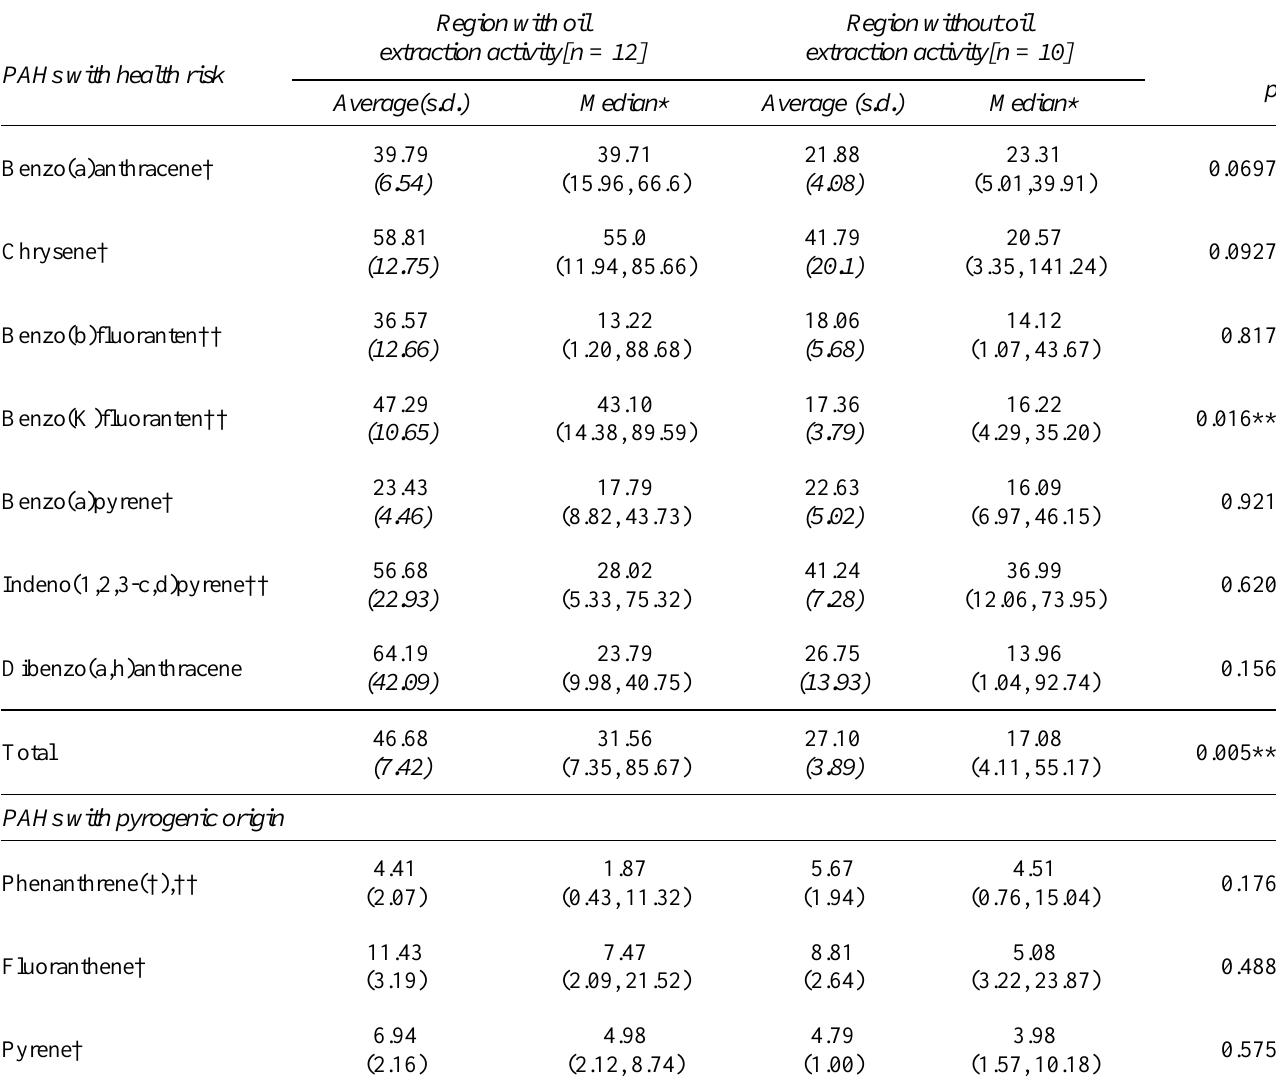
Table 3 : Health risk PAHs and Pyrogenic PAHs Concentrations (ng m -3 ) in regions with and without oil extraction activity. Number of samples [n = ] are under each region